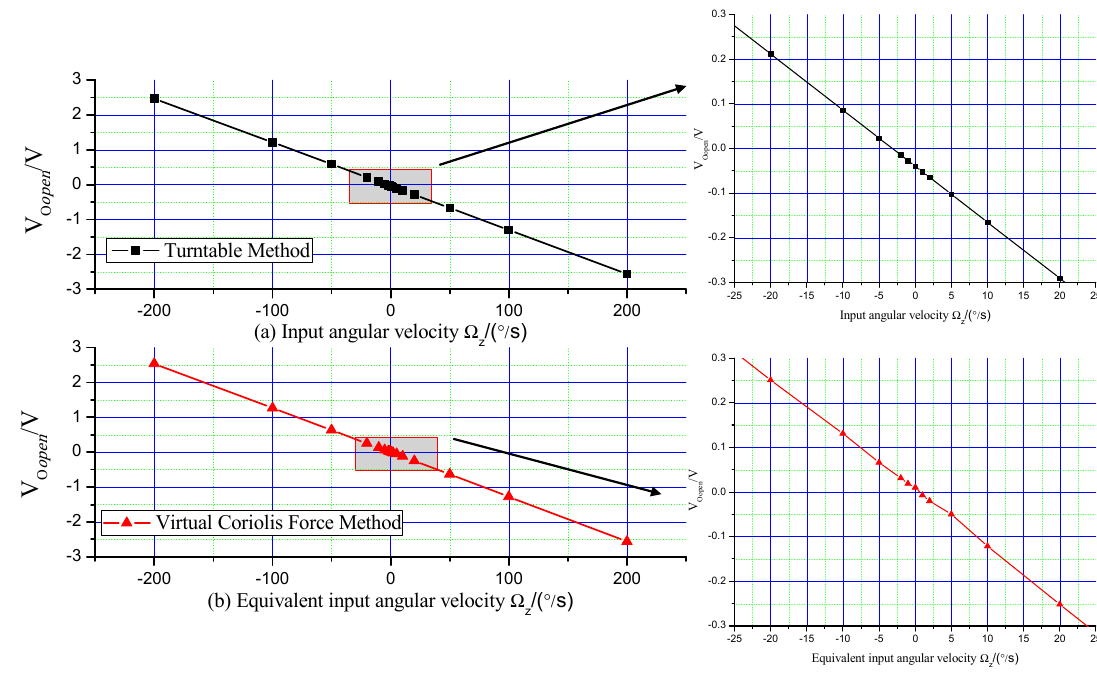
Figure 6. Calibration results of turntable method and the virtual Coriolis force method.